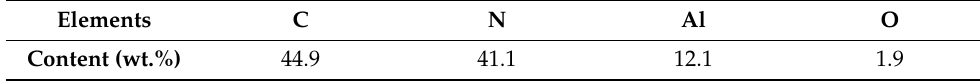
Table 3. EDXS spectra acquired on the gCN